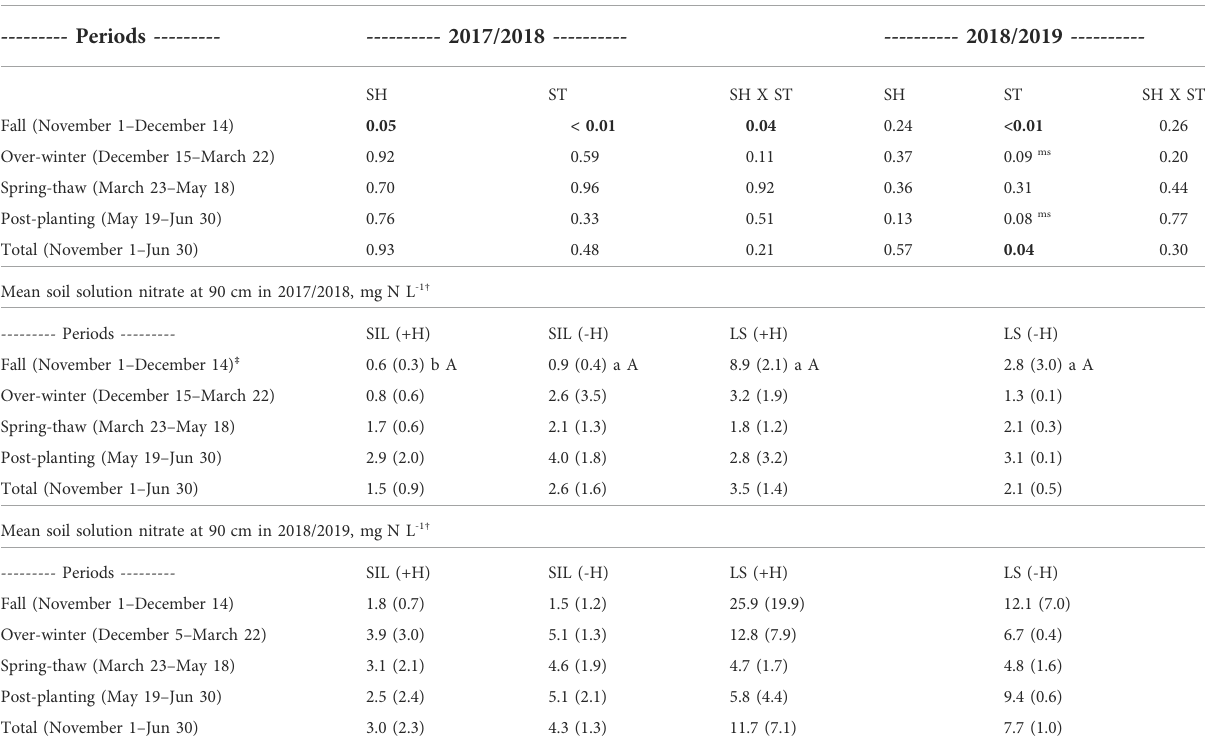
TABLE 2 p -values of the two-way ANOVA used to test main effects (SH, soil heating; ST, soil type) and the interaction SH × ST on the nitrate concentration at 90 cm, for periods of the 2017/2018 and 2018/2019 seasons, and respective averages (standard deviation is shown in parenthesis). Bolded values indicate p ≤